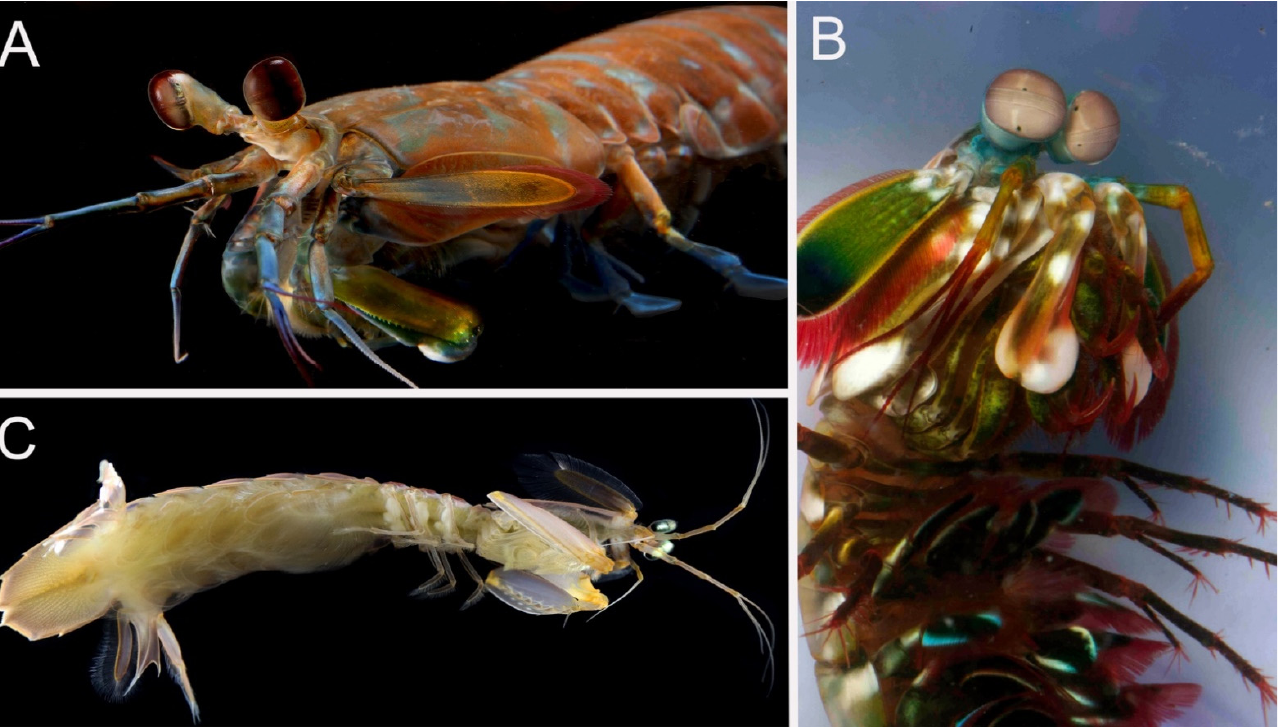
Figure 1. Photographs of Stomatopoda showing the range of raptorial claws. ( A ) ‘Intermediate’ claw form: Hemisquilla californiensis from California. ( B ) Smasher: Odontodactylus scyllarus from New Guinea (not used in this study). ( C ) Spearer: Squilla biformis from off Pacific Costa Rica.